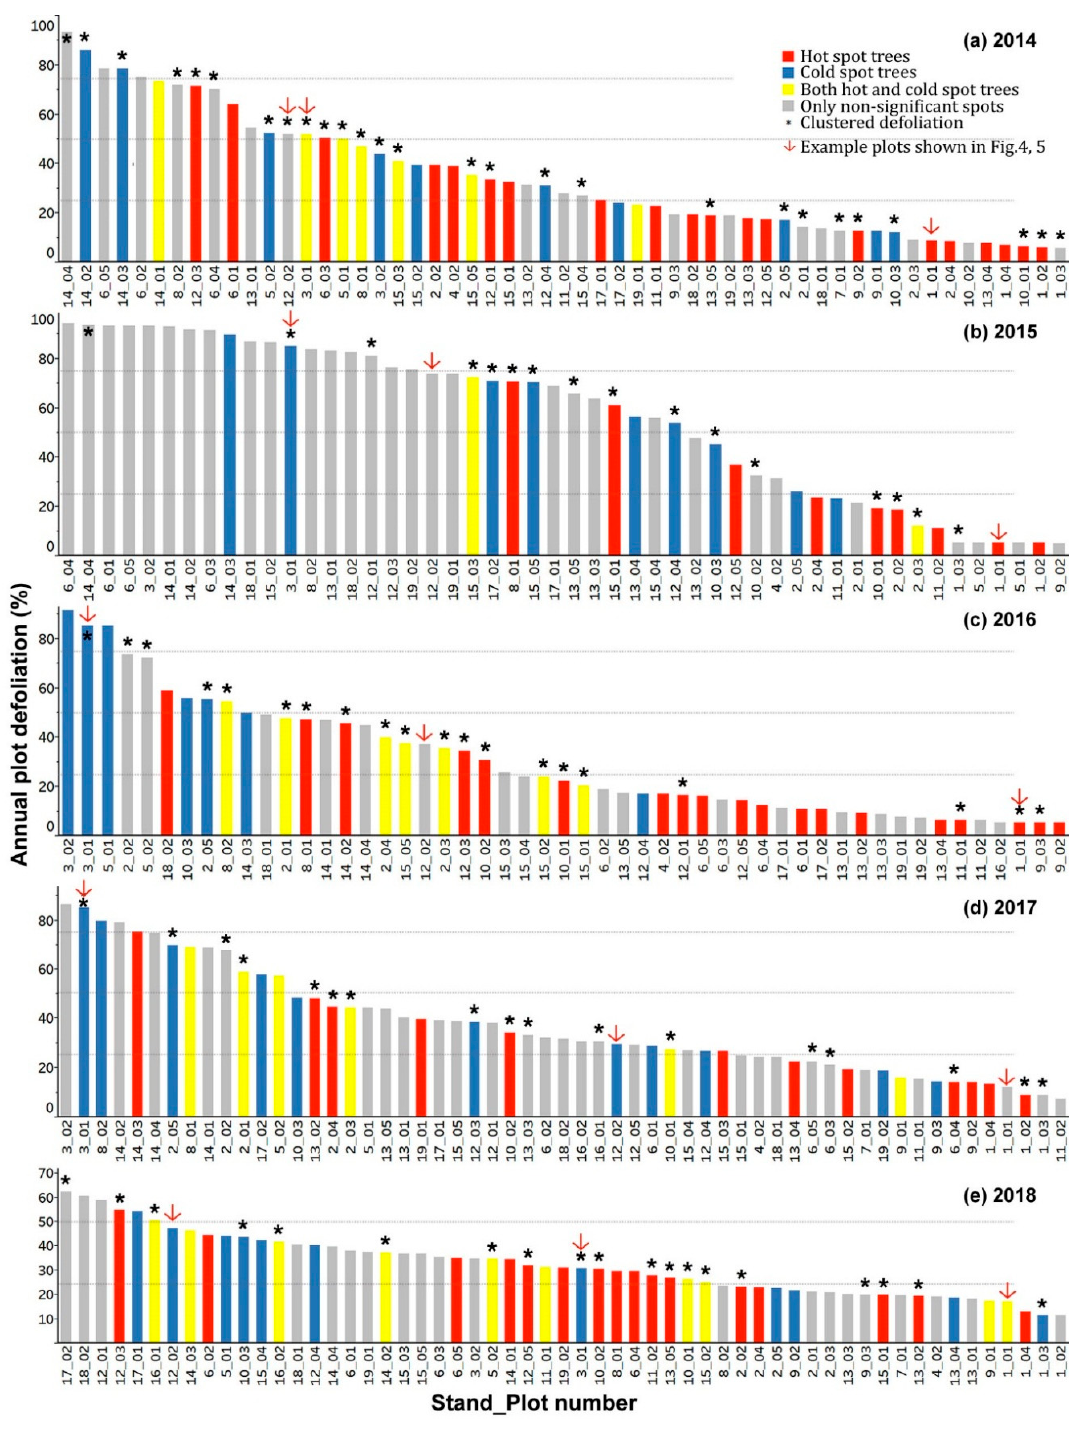
Figure 2. Average current year defoliation of plots, ordered from highest to lowest defoliation each year from 2014 to 2018 ( a – e ), showing plots with significantly clustered ( α = 0.05) defoliation (*), with hot spot trees ( red ), cold spot trees ( blue ), both hot and cold spot trees ( yellow ), and only non-significant trees ( grey ), based on results of Getis-Ord Gi* analyses ( α = 0.05). There was a tendency for highly defoliated plots to have more cold spot trees, and lightly defoliated plots to have more hot spot trees (Figure 2). Over the five sampled years, plots with 0%–25% defoliation had 0–4 cold spots (0.3 on average) and 0–8 hot spots (1.0 on average), while plots